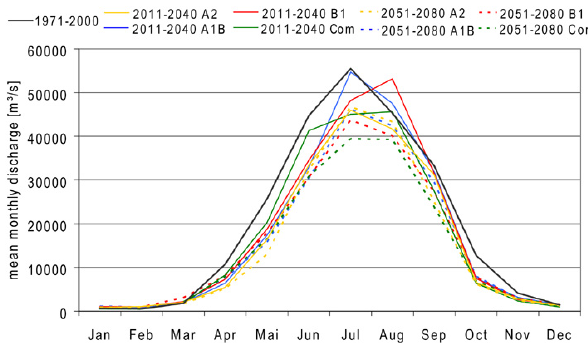
Figure 15. Developing of the mean monthly discharge in the UBRB for the past from 1971–2000 in comparison to the 30-years period from 2011–2040 and 2051–2080.